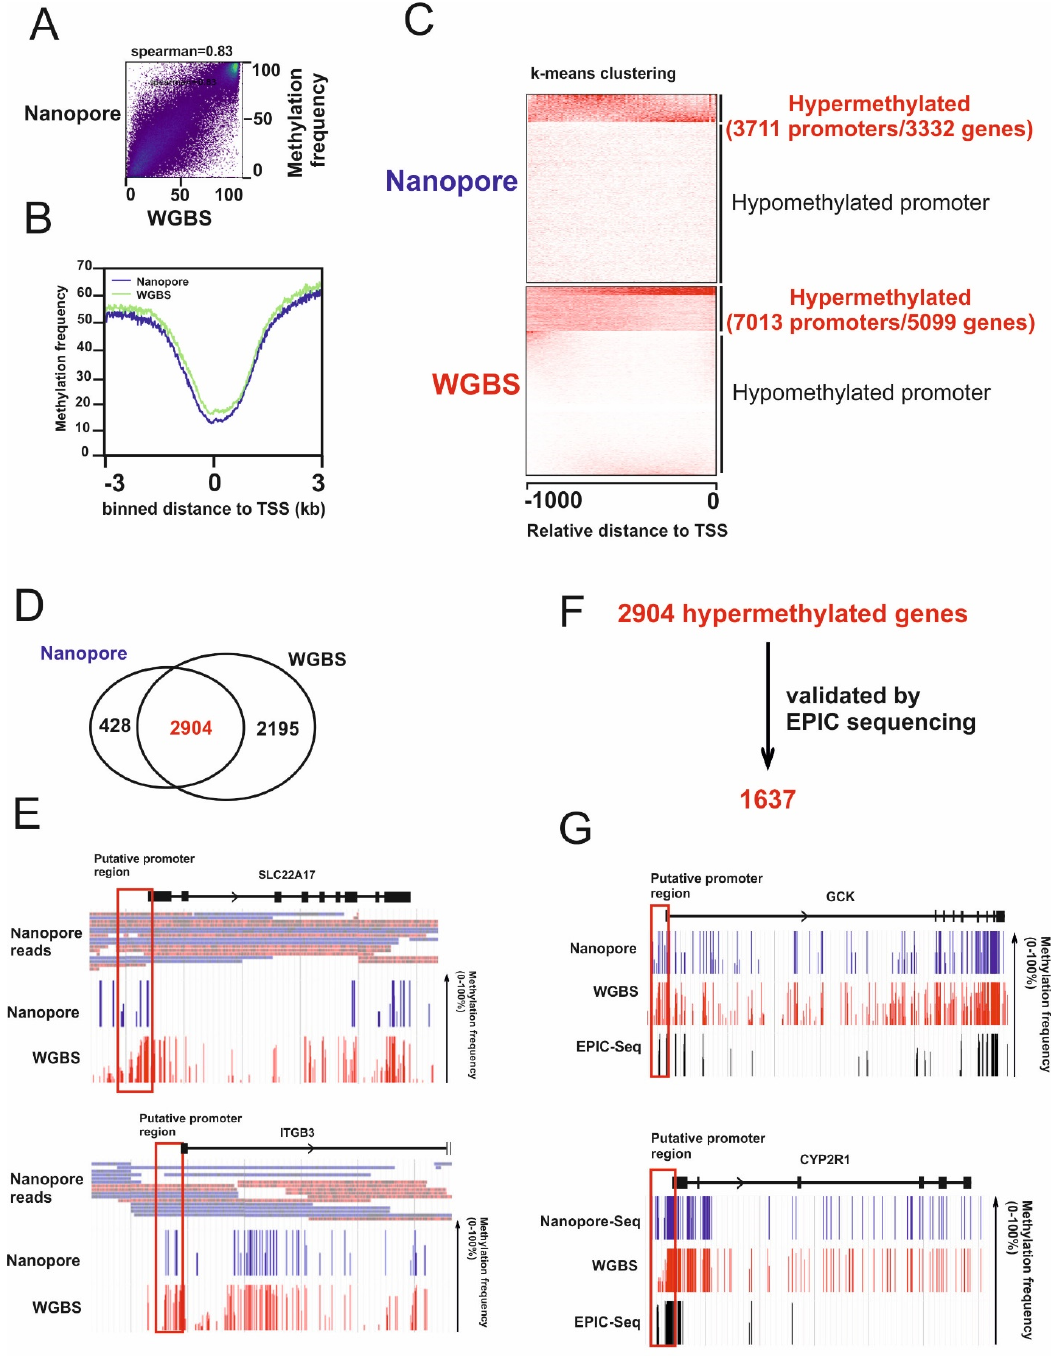
Figure 1. Identification of hyper-5mC genes in hepatocellular carcinoma (HCC). ( A ) Scatterplot showing the correlation between methylation frequencies generated by nanopore sequencing versus WGBS. ( B ) Metaplot of the nanopore and whole-genome bisulfite sequencing (WGBS) methylation calls around annotated transcription start sites (TSSs). ( C ) k- means clustering on 29598 promoters of 16455 genes (Eukaryotic Promoter Database) was performed for methylation calls generated by nanopore and WGBS. ( D ) Common hypermethylated genes detected by nanopore and WGBS. ( E ) Nanopore read coverage and methylation profile of glucokinase (GCK) and CYP2R1 gene generated by nanopore and WGBS were visualized using JBrowse. ( F ) A total of 1637 hypermethylated genes detected by nanopore and WGBS were confirmed by EPIC sequencing. ( G ) Methylation profile of GCK and CYP2R1 gene generated by nanopore, WGBS, and EPIC sequencing was visualized using JBrowse. Red boxes indicate putative promoter